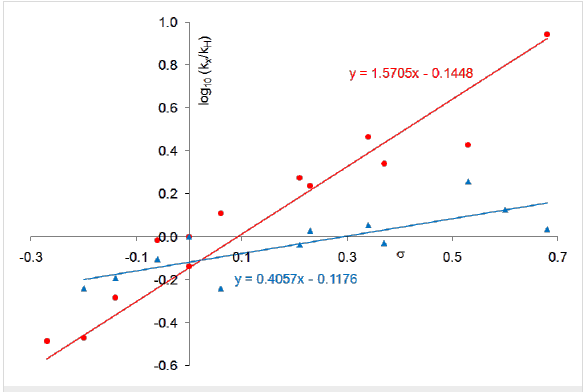
Figure 9: Hammett correlations with catalyst 2 at 0 °C. Data in red are obtained in dichloromethane [52], whilst data in blue are obtained in propylene